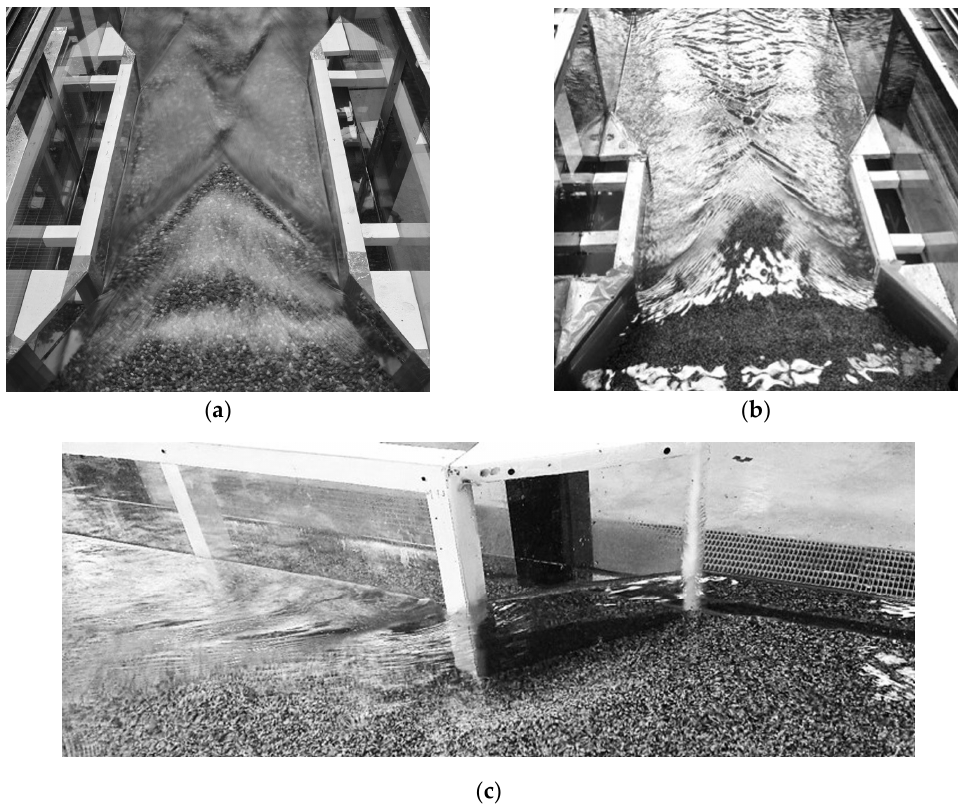
Figure 1. Free surface characteristics for runs 11 ( a ) and 16 ( b ). Flow streamlines and local scour at the contraction inlet for run 20 ( c ).